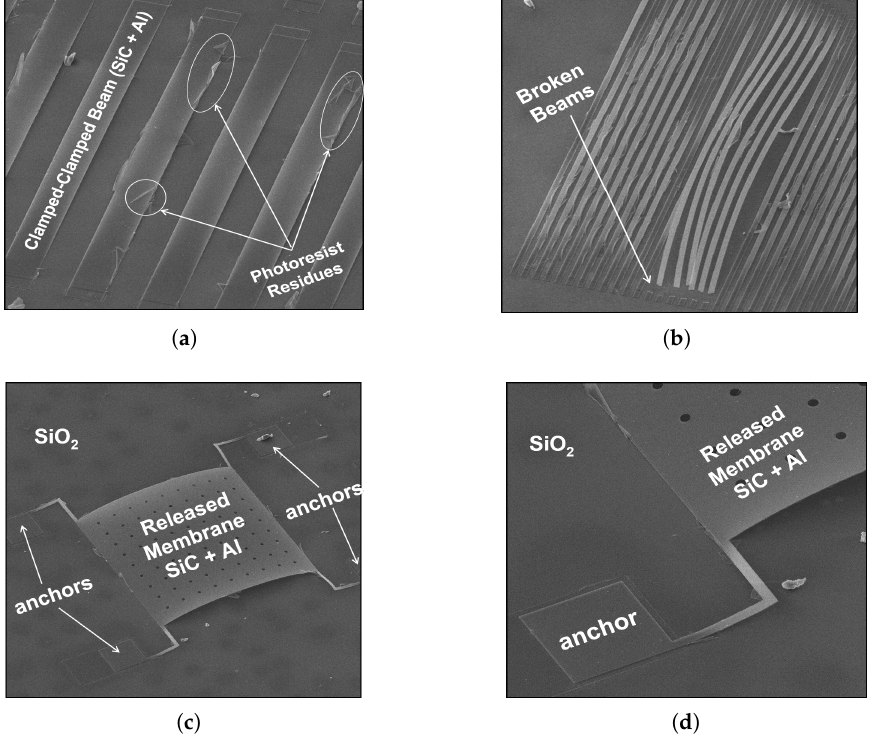
Figure 2. Scanning electron microscope (SEM) images of fabricated and released test structures, using the complete process flow without the Ti layer: ( a ) clamped–clamped beams; ( b ) clamped–clamped beams broken due to high ultrasonic power; ( c ) rectangular membrane suspended by four L-shaped beams; ( d ) close-up of one of the membrane’s